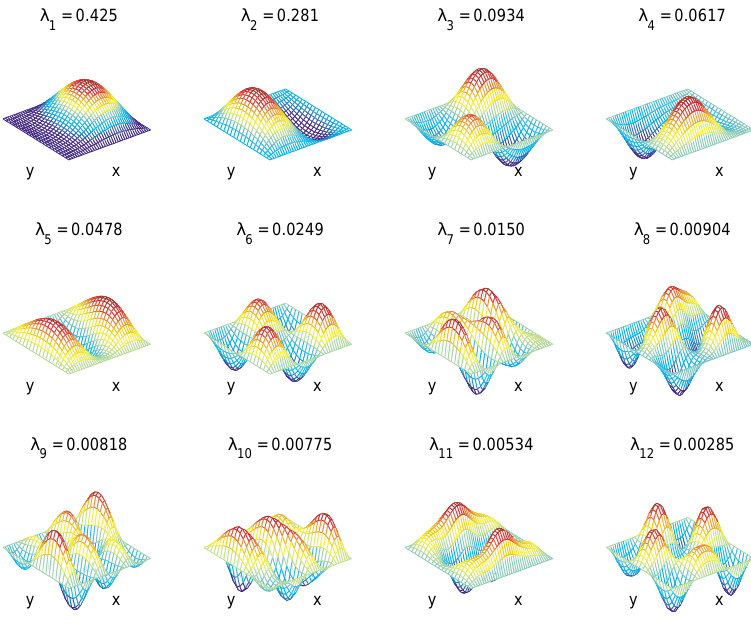
Fig. 14. Effect of reducing sample time on